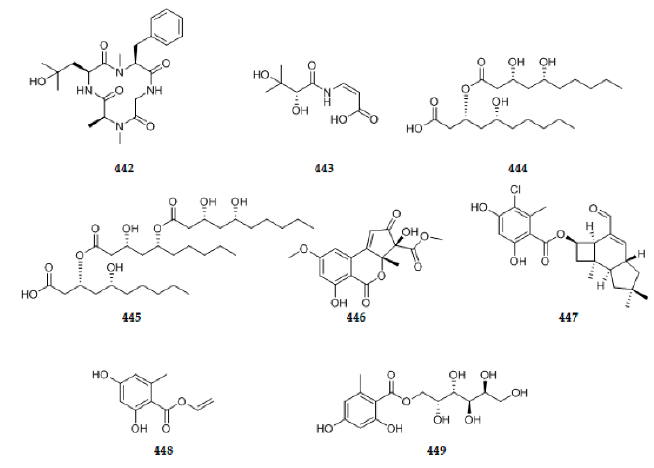
Figure 12. Chemical structures of other new compounds.